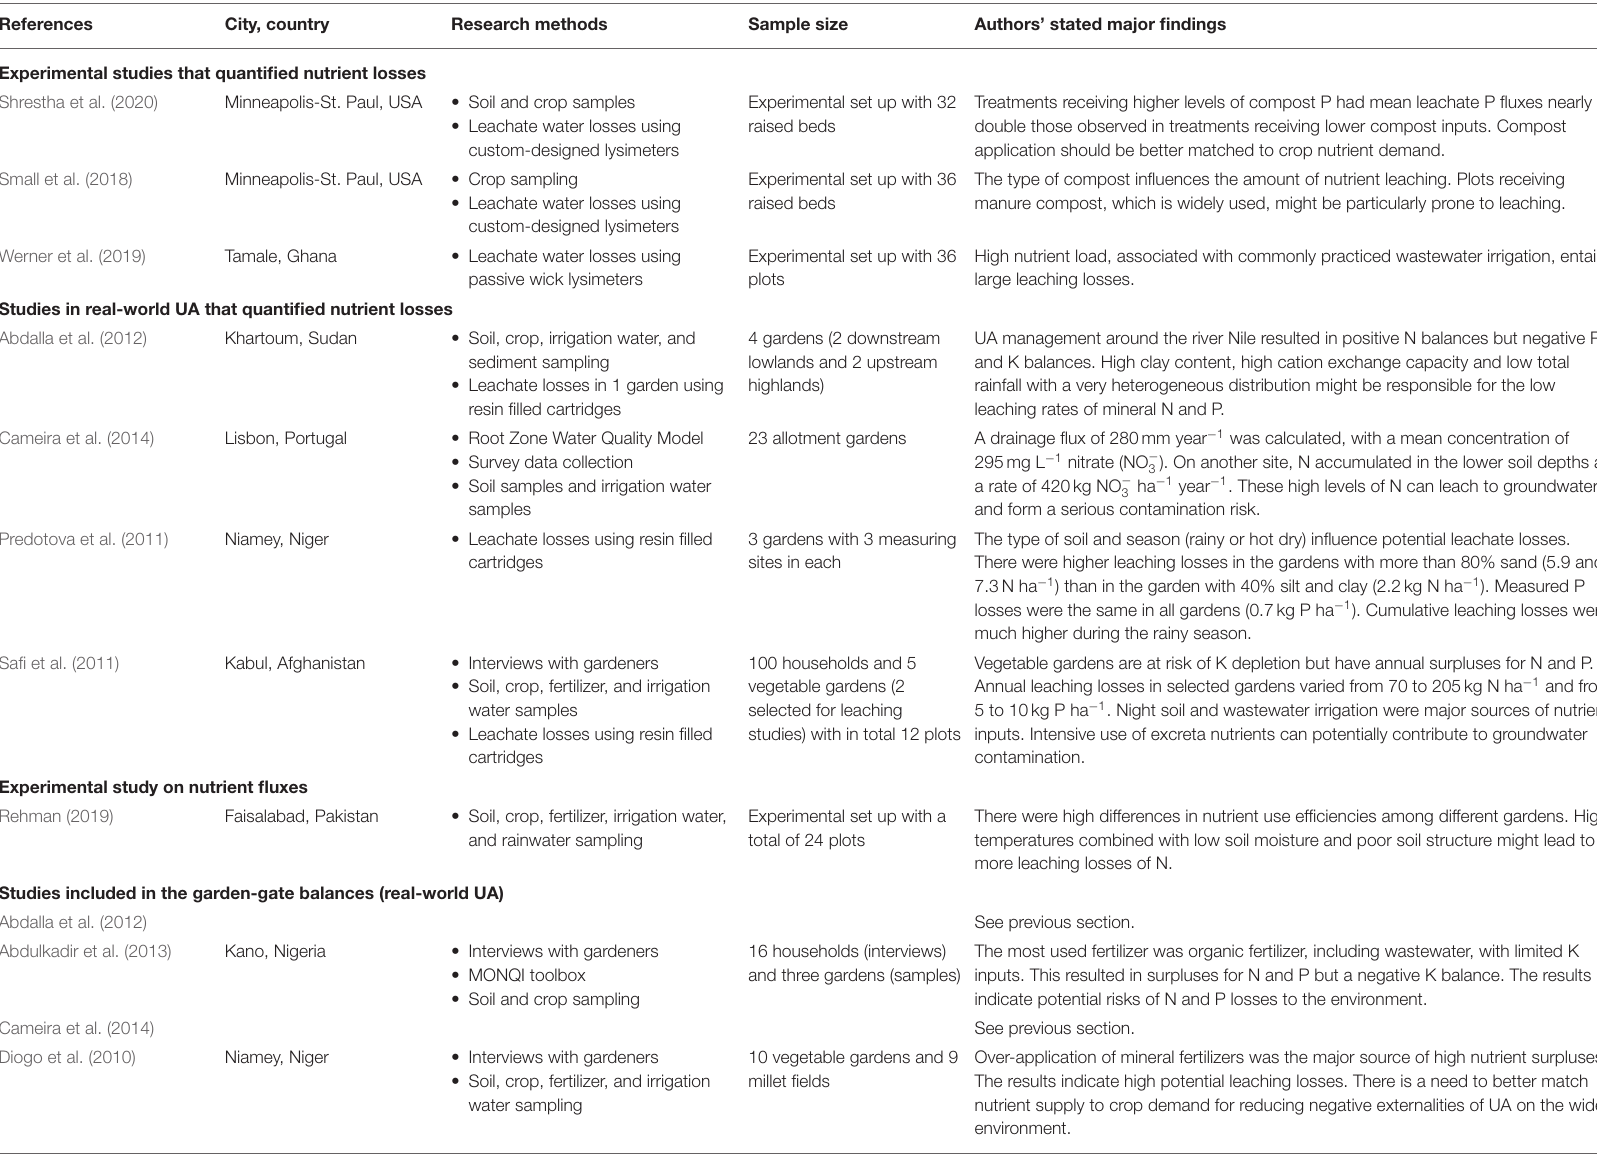
TABLE 2 | Summary of the 20 peer-reviewed studies (2000–2021, focused on soil- and ground-based UA and losses to waters) retained through the review